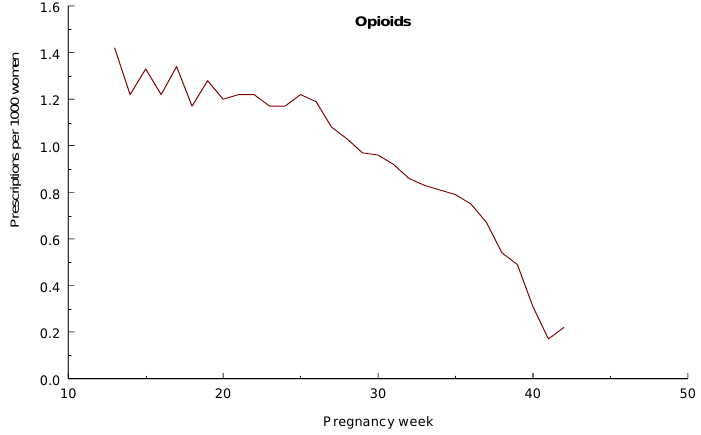
Figure 1. Number of women who had filled a prescription for an opioid for each gestational week.